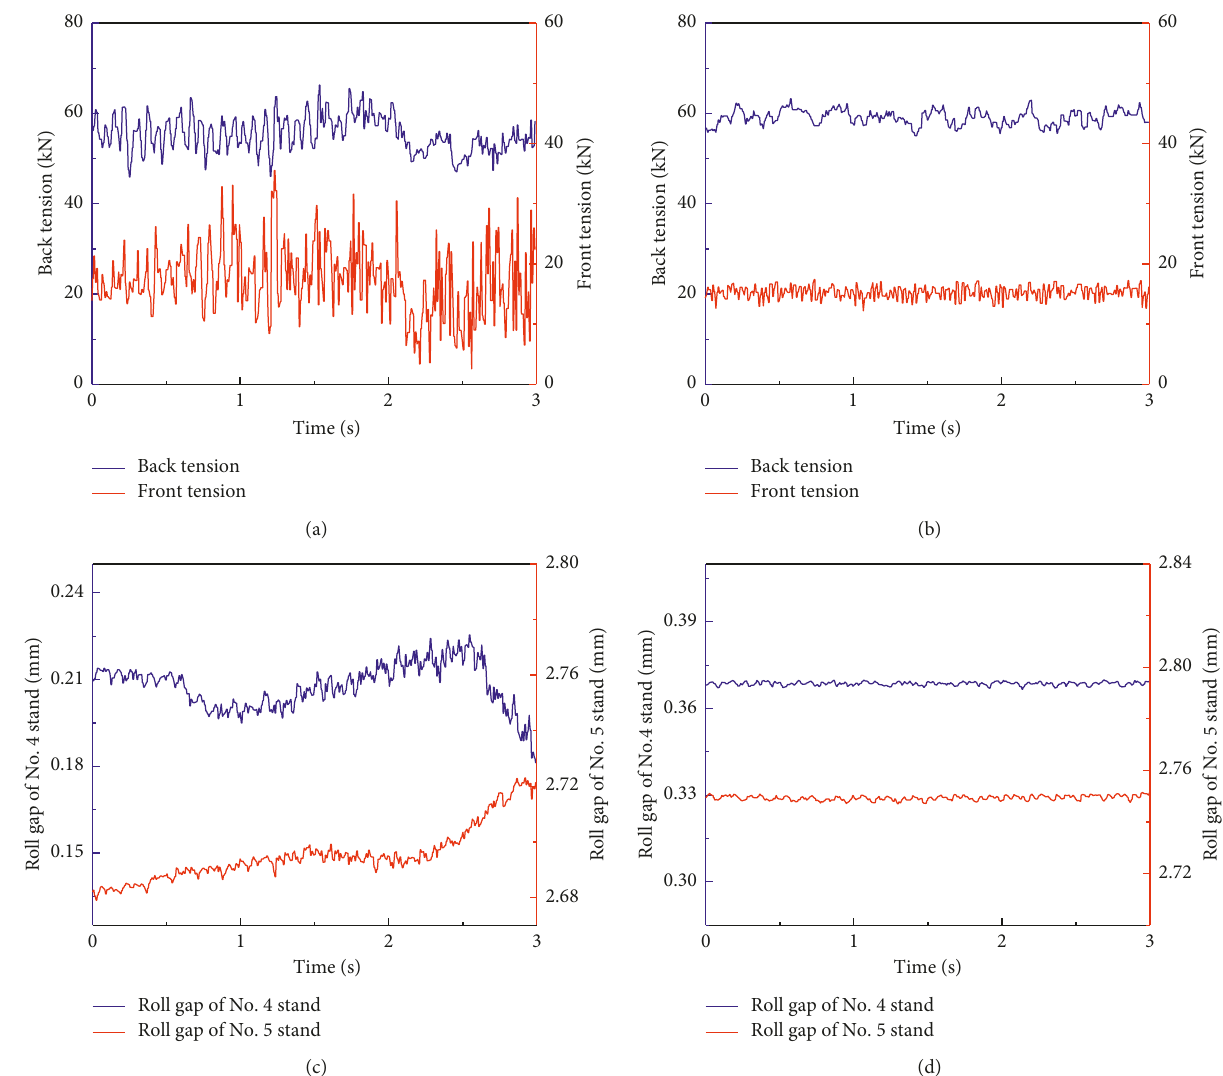
Figure 11: Tension and roll gap time history: (a) back and front tension of No. 5 stand under the speed of 23.0m/s; (b) back and front tension of No. 5 stand under the speed of 22.1m/s; (c) roll gap of No. 4 and No. 5 stands under the speed of 23.0m/s; (d) roll gap of No. 4 and No. 5 stands under the speed of 22.1m/s.